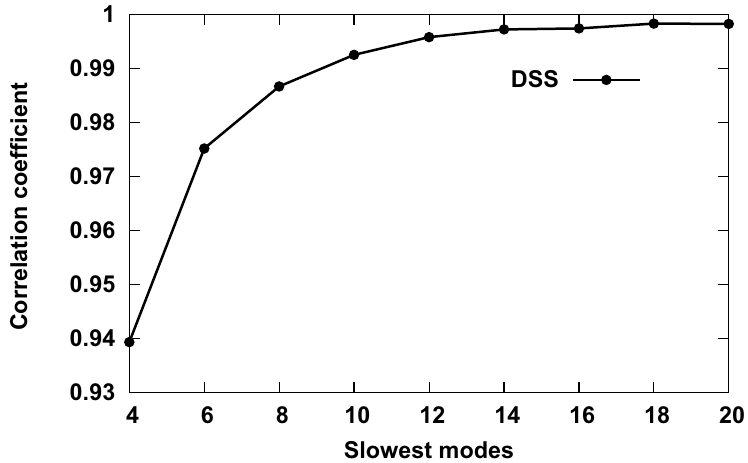
Fig 1. Correlation coefficient between DSSs calculated with different number of slow modes. The calculations were performed for globin chains in dataset1. The first data point (Slowest modes value 4) marks the correlation coefficients between DSS scores calculated using the 2 and 4 slowest modes, with the second between DSS scores calculated using the 4 and 6 slowest modes, and so